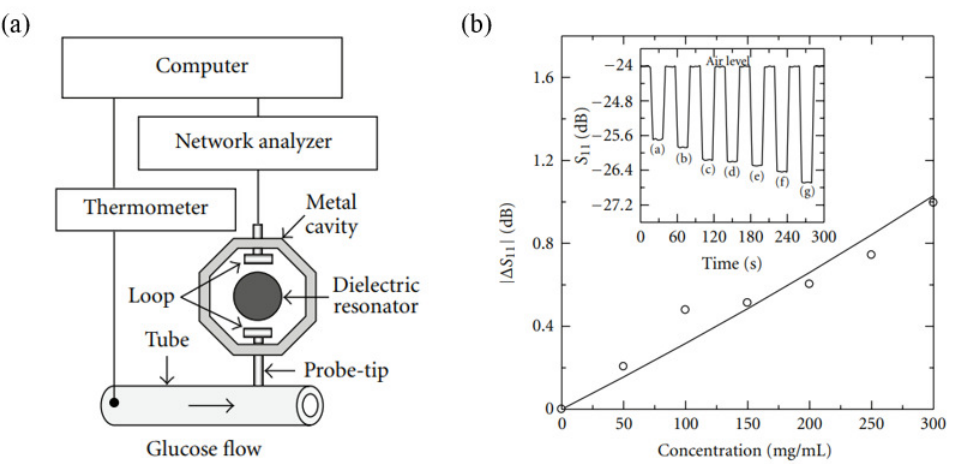
Figure 6. Glucose concentration detection using a TM 011 mode metal cavity and a near-field micro- probe. ( a ) Experimental setup for glucose concentration detection. ( b ) Change in reflection coefficient hias a function of the glucose concentration. The inset represents a real-time diagram of the reflection coefficient for different DI water concentrations to 300 mg/mL. ((a) DI water, (b) 50 mg/mL, (c) 100 mg/mL, (d) 150 mg/mL, (e) 200 mg/mL, (f) 250 mg/mL, and (g) 300 mg/mL) [66]. Lee et al. proposed a glucose sensor based on a dielectric resonator, a TE 011 mode cavity, and a microwave microprobe [67]. The resonant frequency of this sensor is 4.5